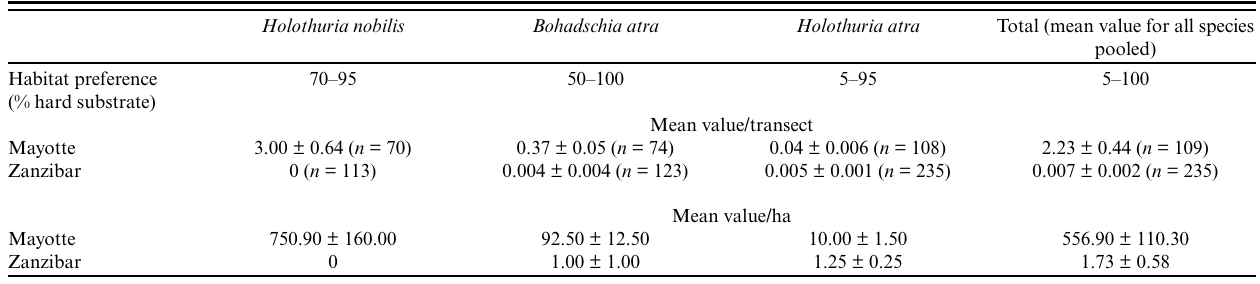
Table 4 . Mean values (US$) ± SE per transect and per ha. Mean values are calculated for transects defined as suitable habitat configuration for each individual